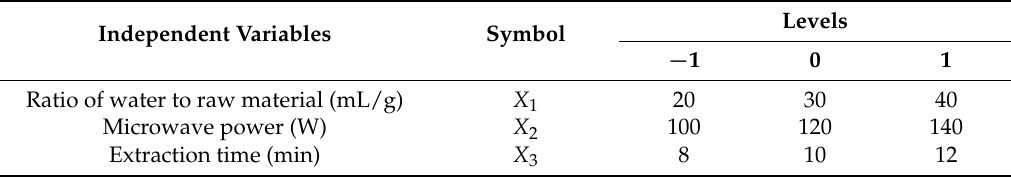
Table 6. Independent variables and their levels used for Box-Behnken design (BBD). Independent Variables Ratio of water to raw material